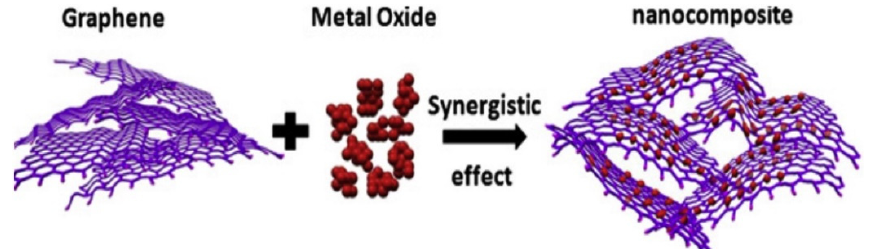
Figure 7. Fabrication of graphene-derived nanocomposite from metal oxide. Reproduced with permission from [78]. Copyright Elsevier, 2019.